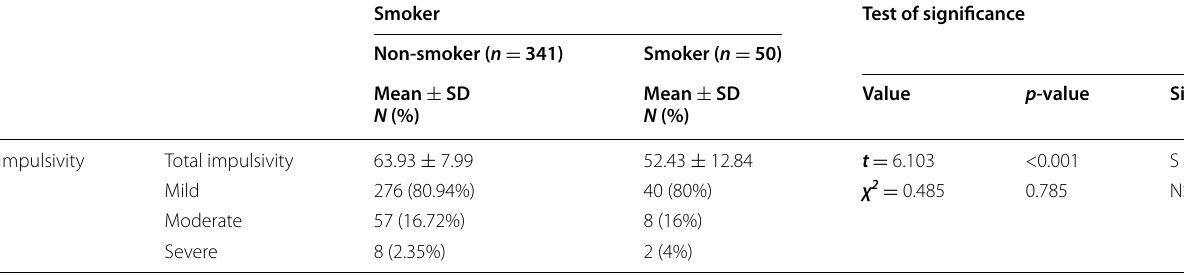
t , Student t -test of significance; χ 2 , chi-square test of